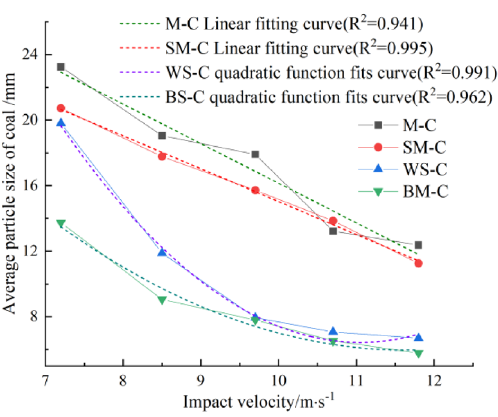
Figure 12. Relationship between average particle size of coal and impact